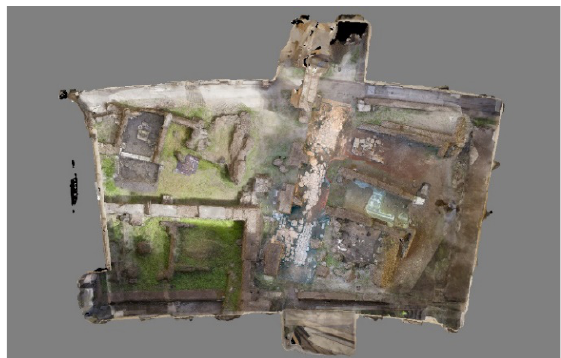
Fig. 17 Archaeological dig in Sant'Omobono: ortophotos of entire site from fig. 15, blended with post-dig ortos from excavated area.